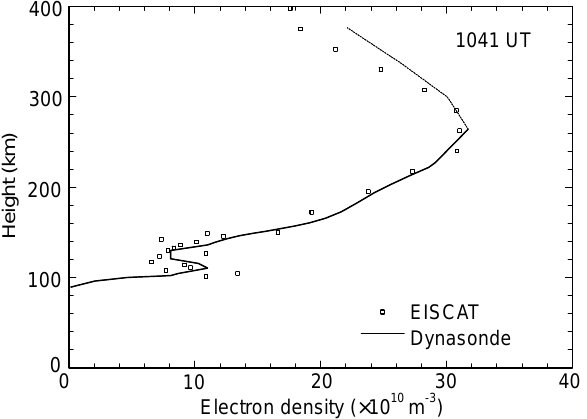
Fig. 1. Combined electron-density profiles from EISCAT and the Dynasonde, taken at 1041 UT, 20 May 1994, during the experiment SP-UK-DYNA. The EISCAT data are of the alternating-code type below 150 km and the long-pulse type above 150 km. They are based on a revised calibration factor derived from Dynasonde-measured F -region peak densities. The Dynasonde profile has been generated using